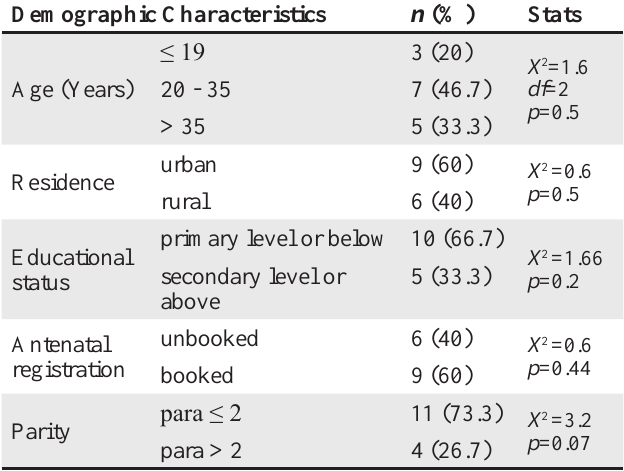
Table 1 : Demographic and obstetric characteristics of the